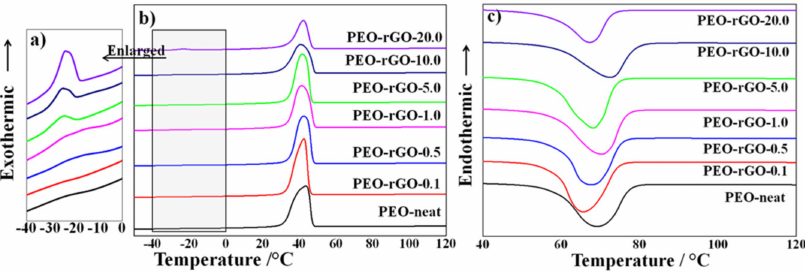
Figure 7. Nonisothermal DSC scans of PEO and rGO-modified samples at a constant scanning rate of 10 ◦ C/min: ( a ) enlargement of the temperature sequence ~ − 25 ◦ C, during cooling, where additional exothermic peaks appear, ( b ) cooling and ( c ) second